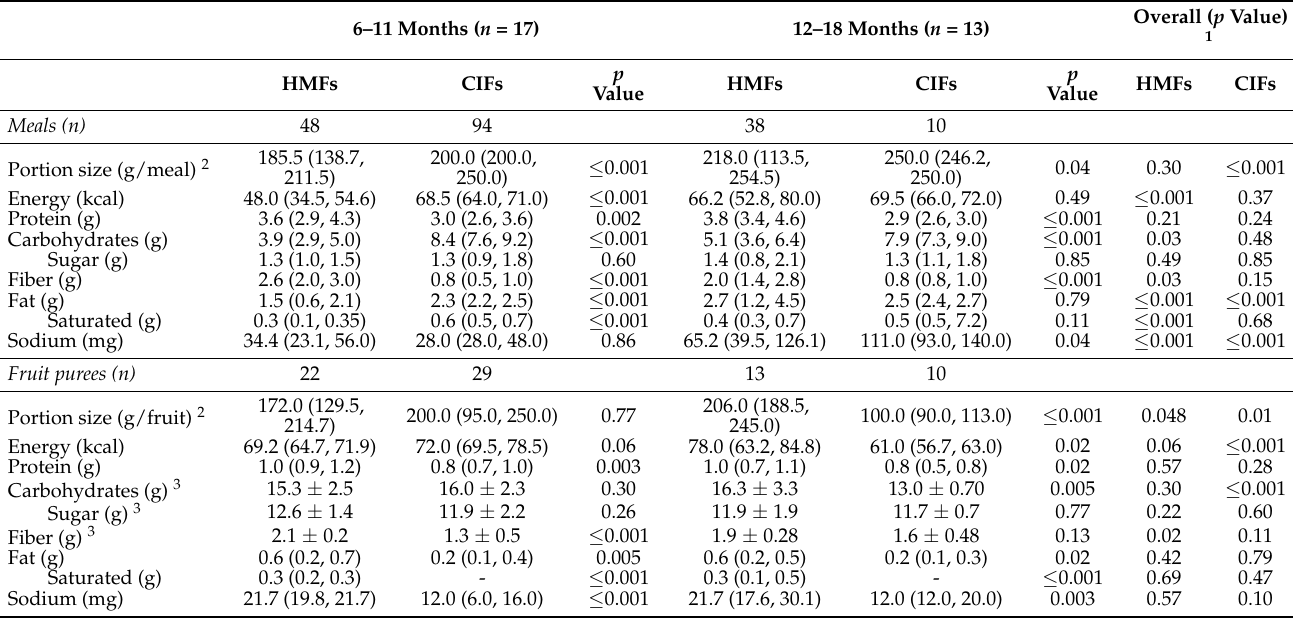
Table 3. Comparison of the nutritional profile (per 100g) of chemically-analyzed HMFs and CIFs for infants (6–11 months) and young children (12–18 months). Values are median (Q1,